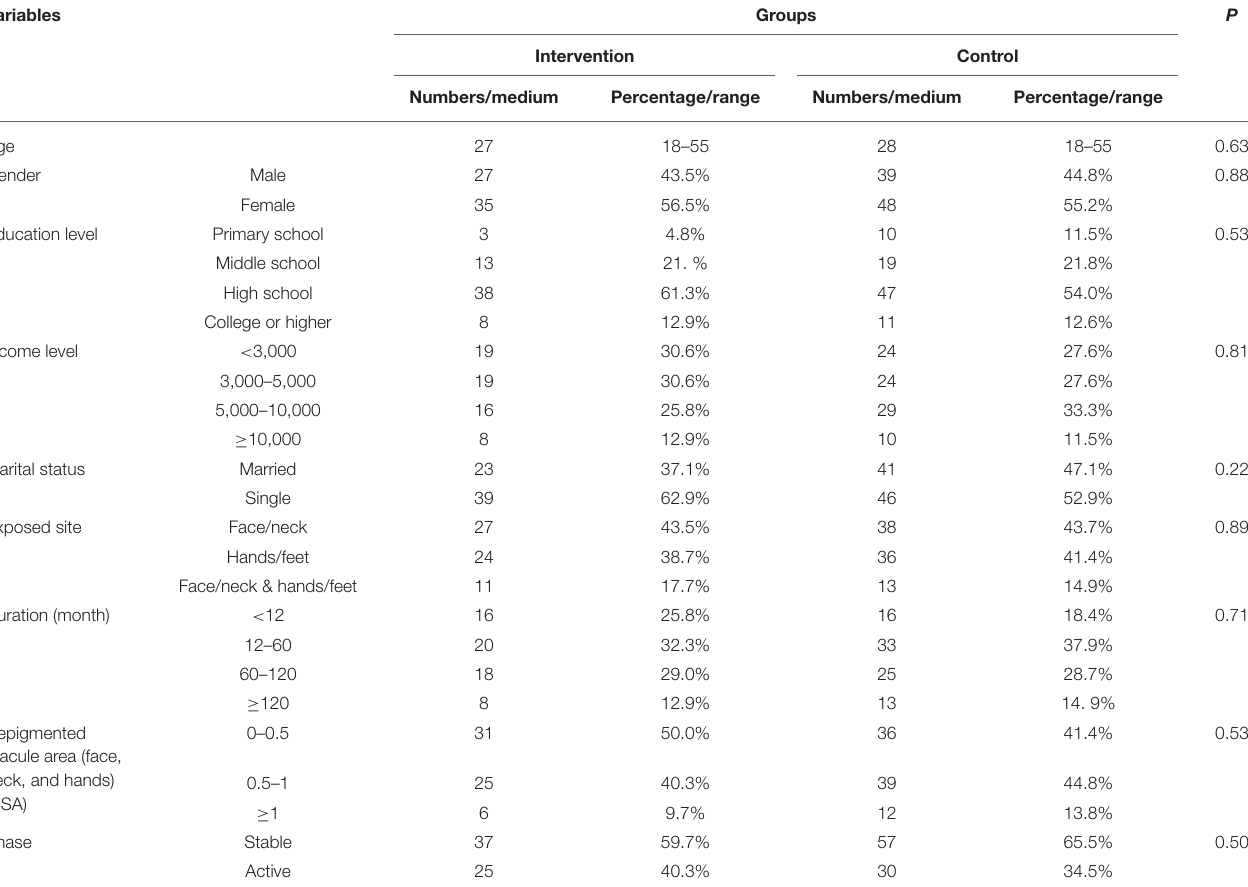
TABLE 1 | Demographics and baseline clinical characteristics of the patients. Variables